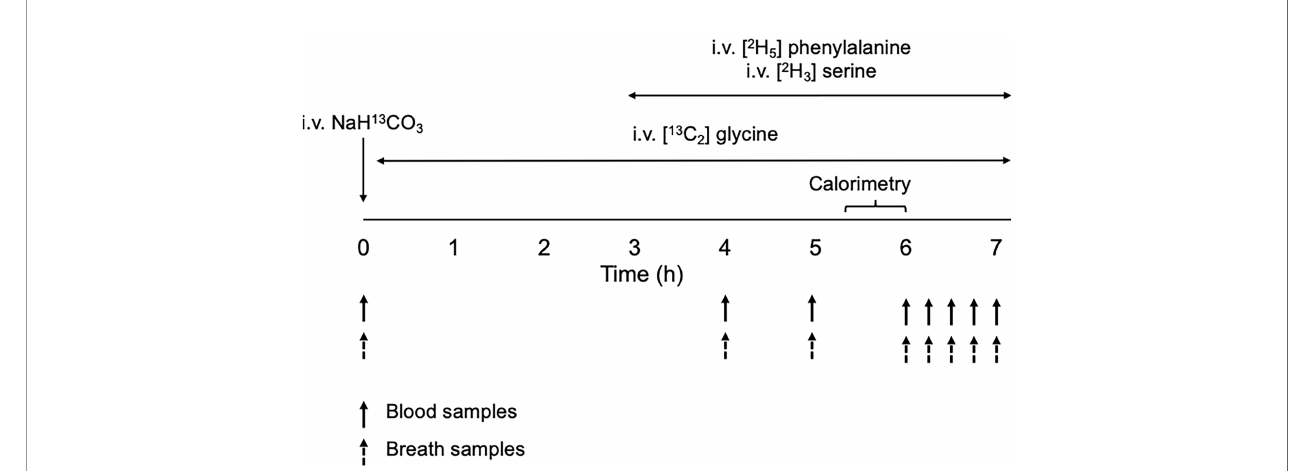
FIGURE 1 | Schematic diagram of the stable-isotope infusion protocol for the measurement of glycine and